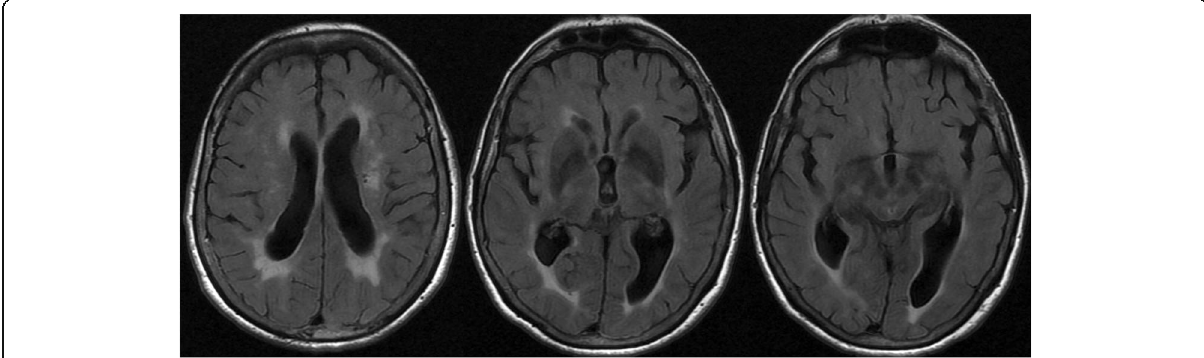
Fig. 1 Axial T2-FLAIR brain MRI: left anterior choroid stroke sequelae and significant peri ventricular vascular white matter hyperintensities without other abnormal